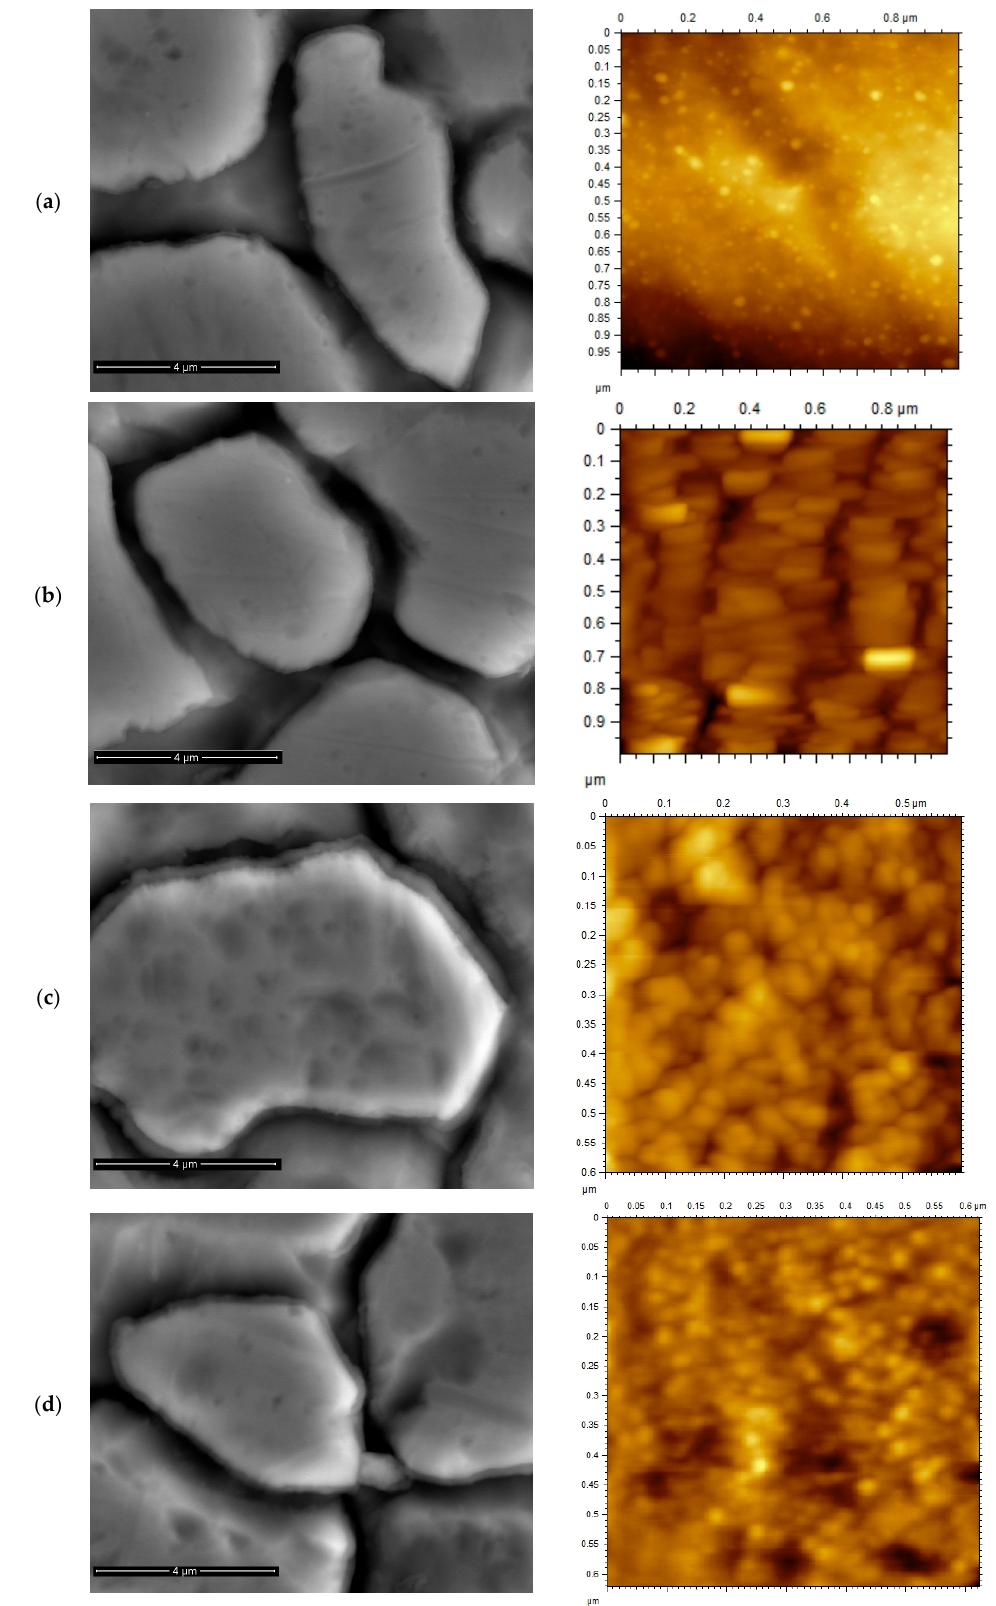
Figure 1. SEM and AFM images of ( a ) TiN thin film, ( b ) TiN x O y thin film, ( c ) TiN after annealing at 400 °C in air, and ( d ) TiN after annealing at 400 °C in vacuum.